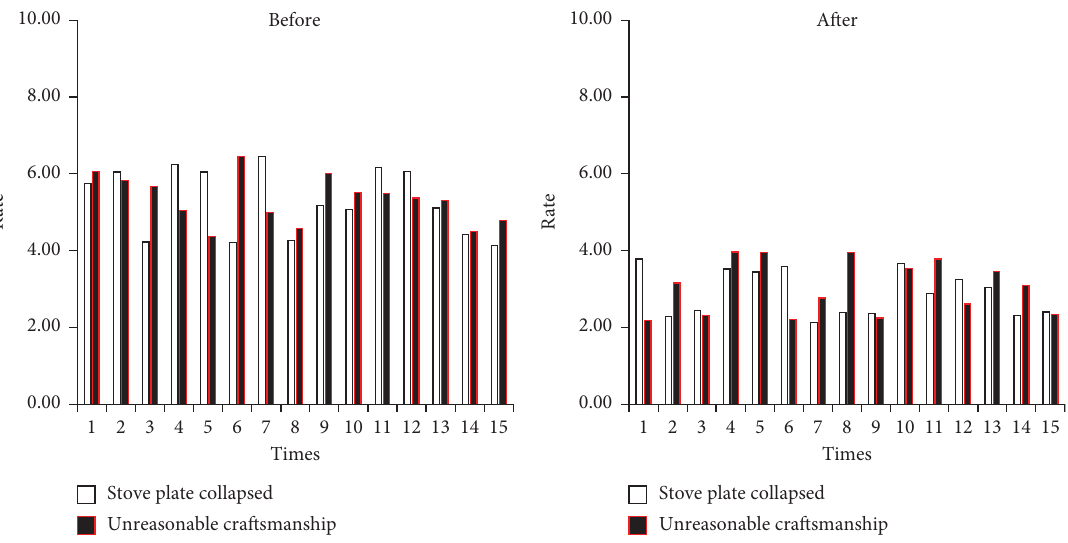
Figure 8: Alumina ceramic tube